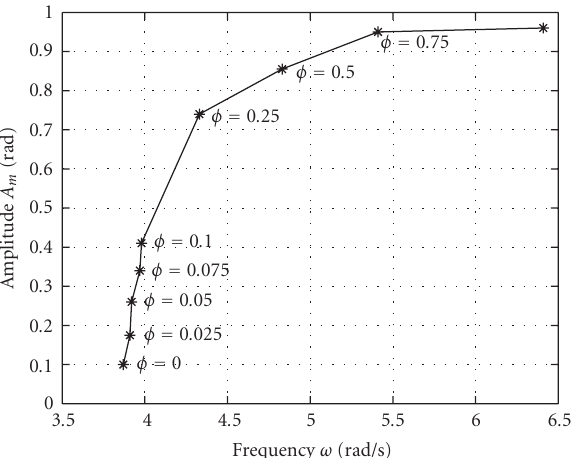
Figure 2: Profile of the frequency and amplitude of oscillations for several values of φ .